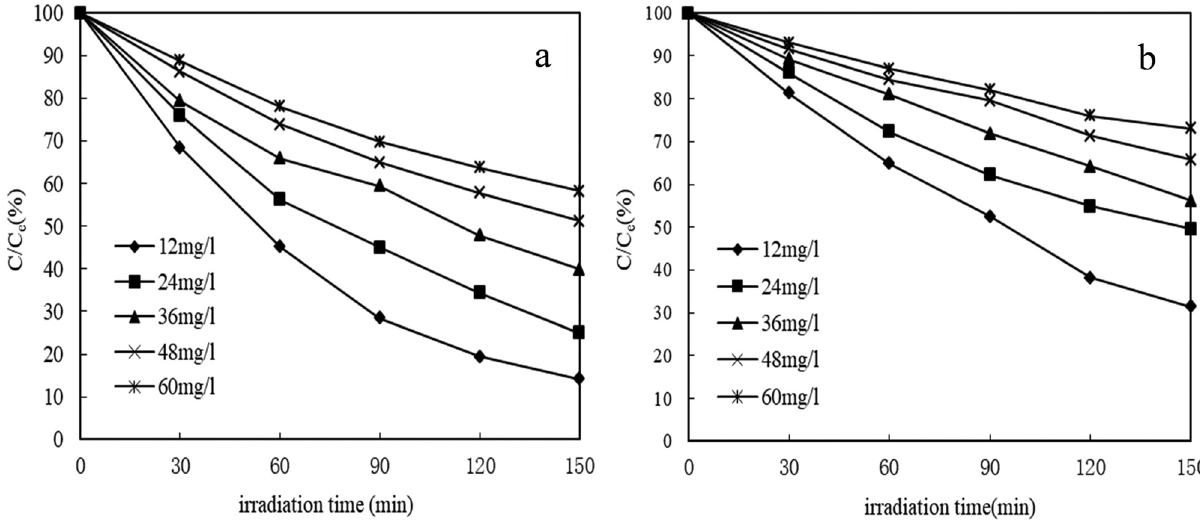
Figure 6: Degradation curves of di ff erent initial concentrations of NB by SiO 2 ( AG ) /T - ZnO ( a ) and T - ZnO ( b ) .